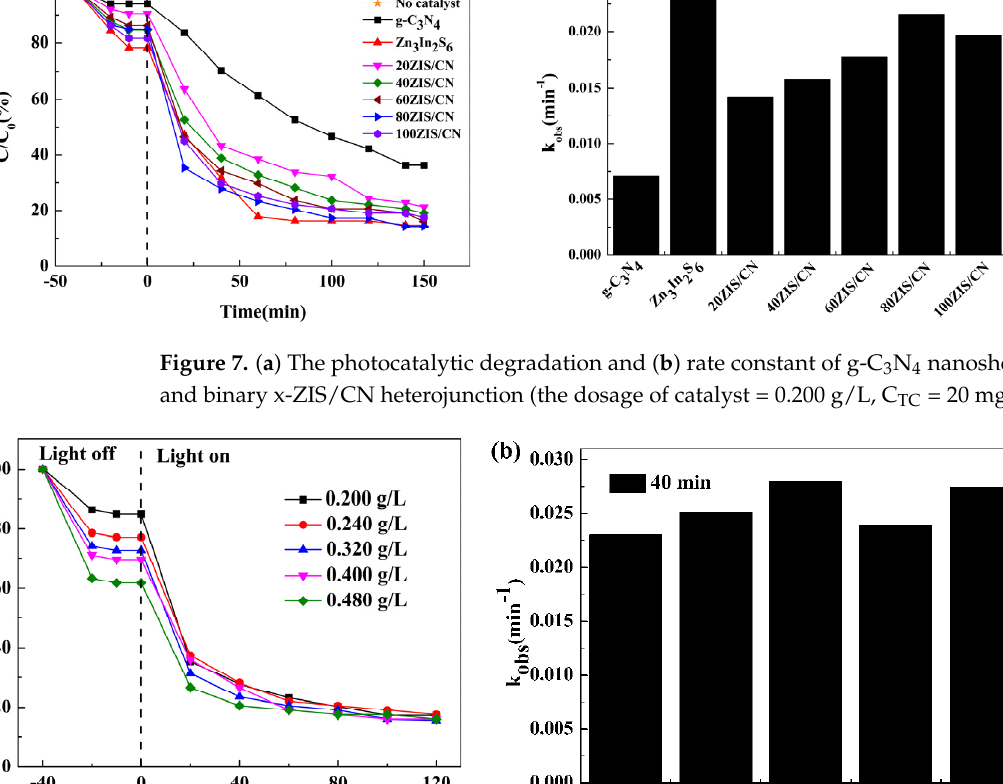
Figure 8. ( a ) Photocatalytic degradation, ( b ) rate constant of different dosage of binary 80ZIS/CN heterojunction for 20 mg/L TC.